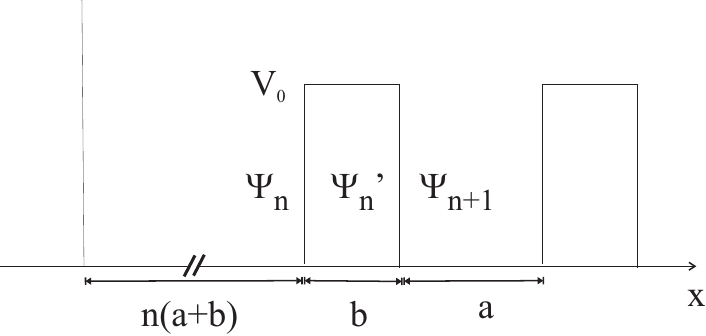
Figure 1. Basic structure of the 1-D